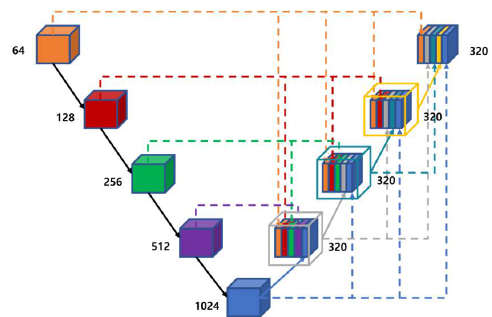
Figure 3. Structure of UNet3+ model